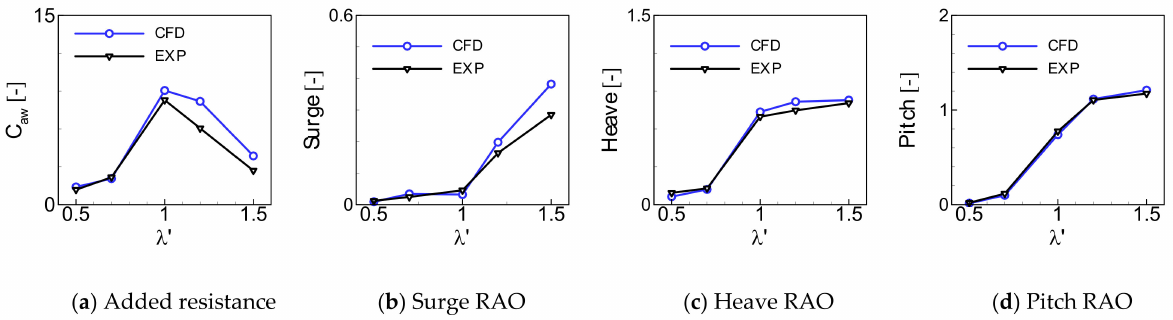
Figure 9. Added resistance and RAOs of the surge, heave and pitch for β 0 = 0 ◦ in head waves.